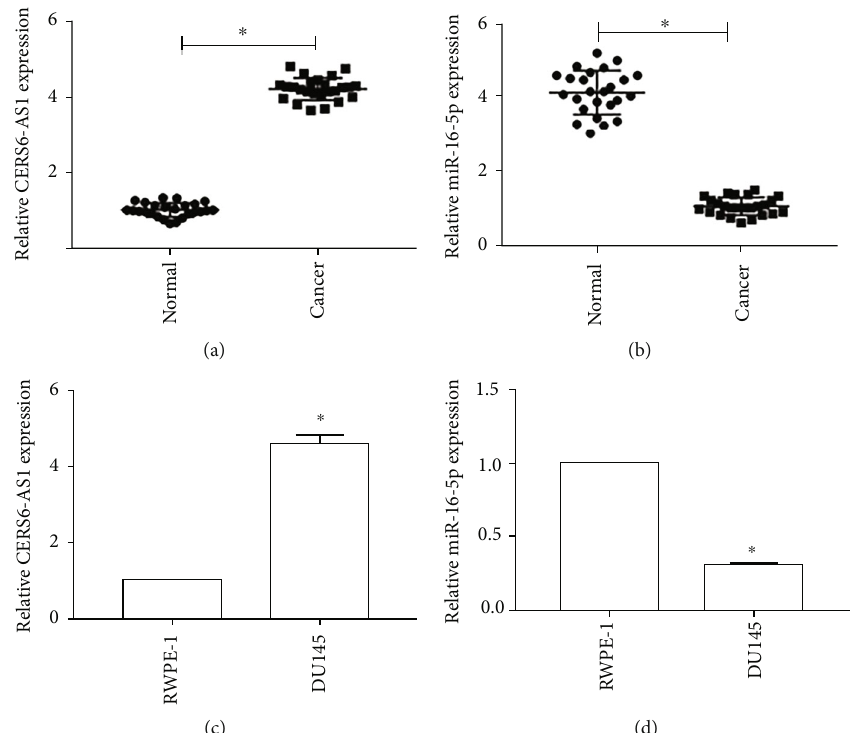
Figure 1: The expression level of CERS6-AS1 and miR-16-5p. (a). The expression level of CERS6-AS1 expression in prostate cancer. (b). The expression level of miR-16-5p. (c). The expression level of CERS6-AS1 expression in prostate cancer cells. (d). The expression level of miR-16-5p expression in prostate cancer cells.